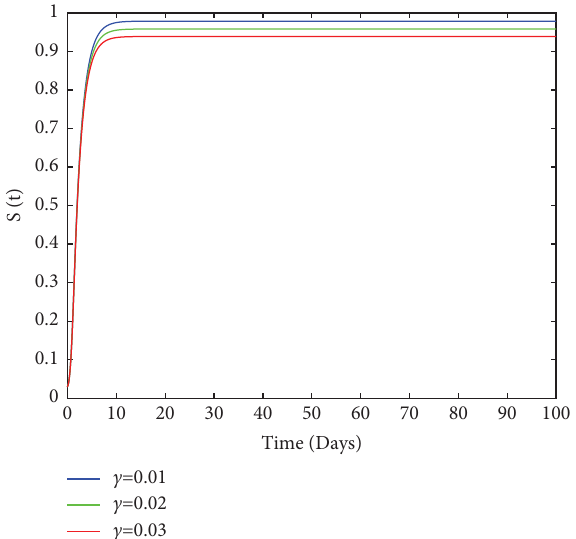
Figure 9: Te density of knowledge disseminators varies with the value of c .